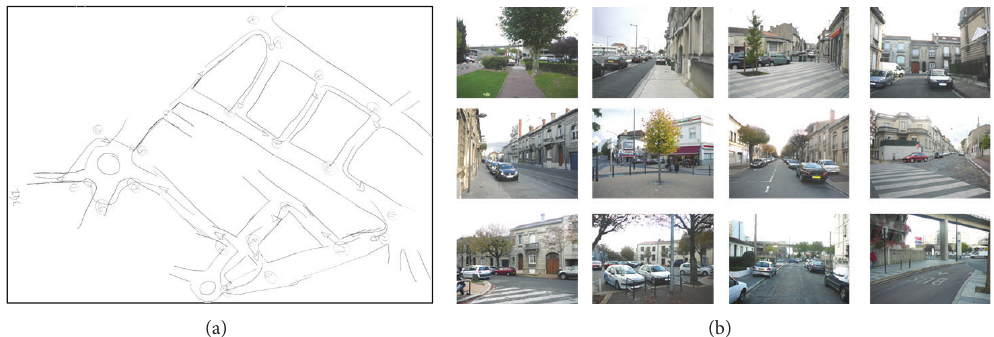
Figure 2: Illustration of the type of result obtained on the sketch-mapping task (a) and of the material used on the picture-sorting task (b) during the recall